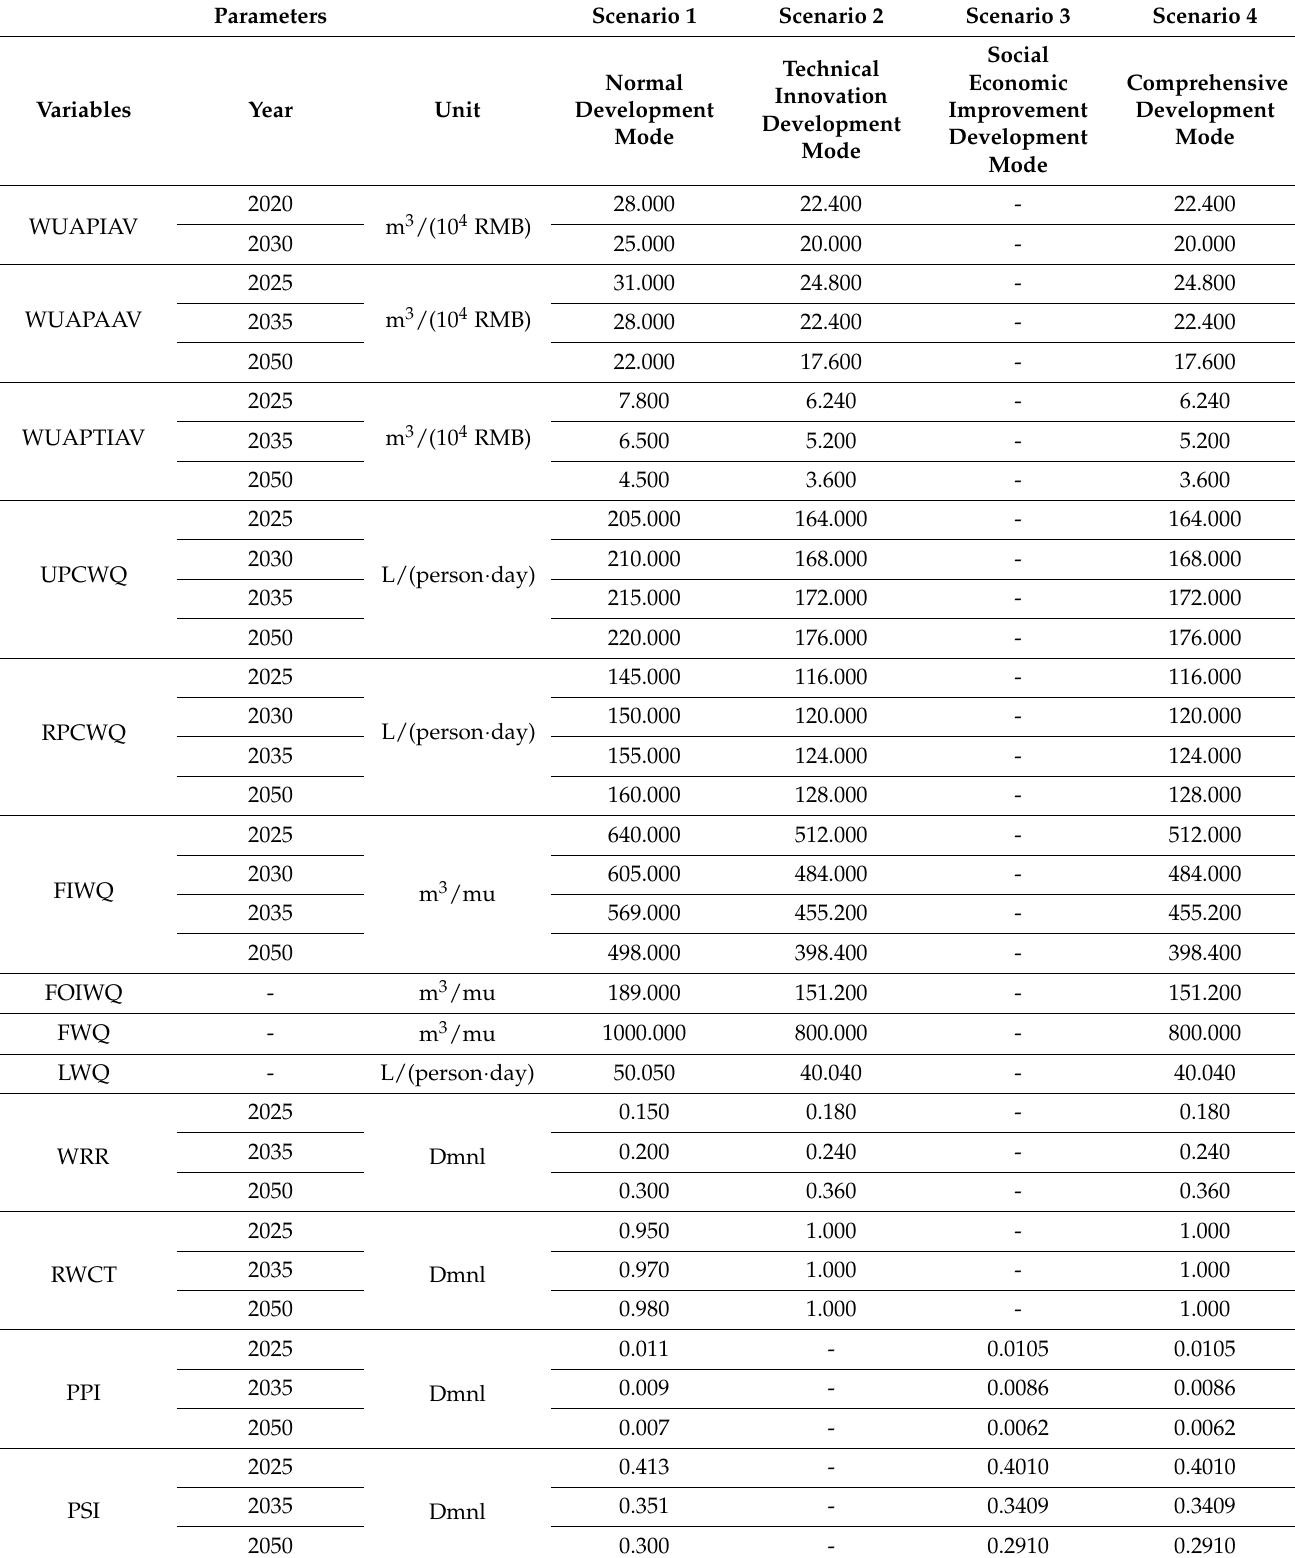
Table A2. Parameter setting of the four different